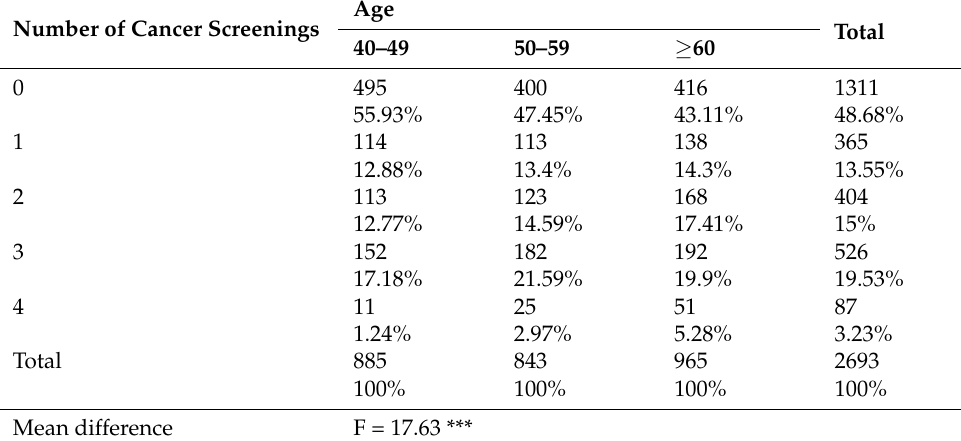
Table 3. Distribution of the number of cancer screenings by age